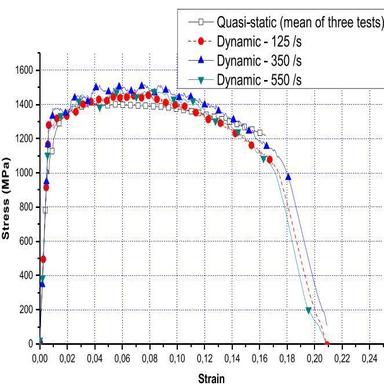
Strain rate effect of the base material 22MnB5 behaviour.